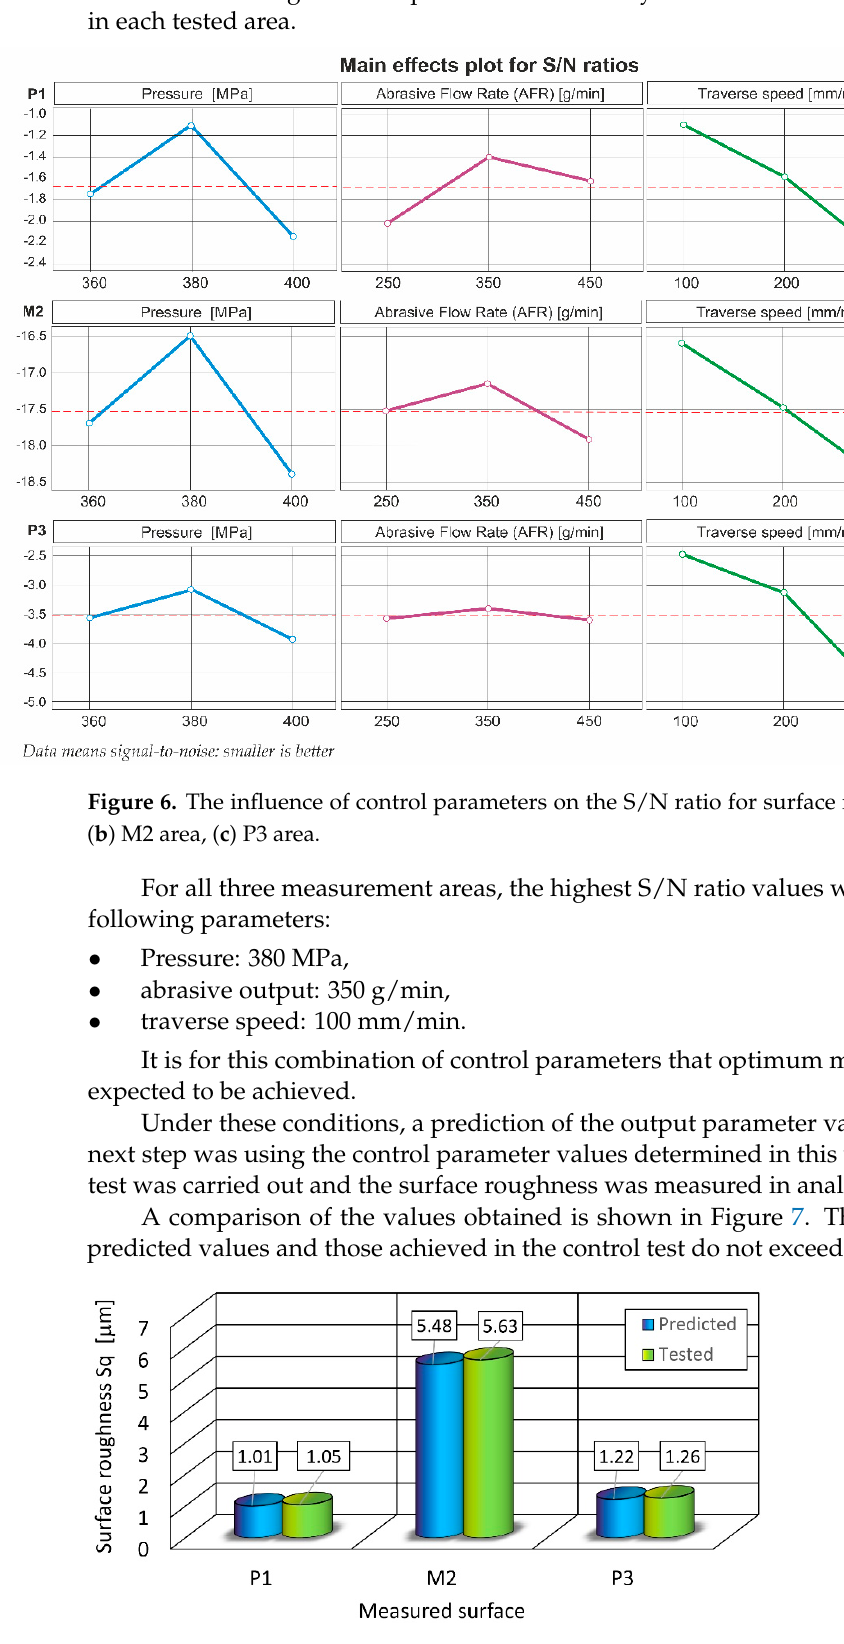
Figure 7. The predicted and tested surface roughness.